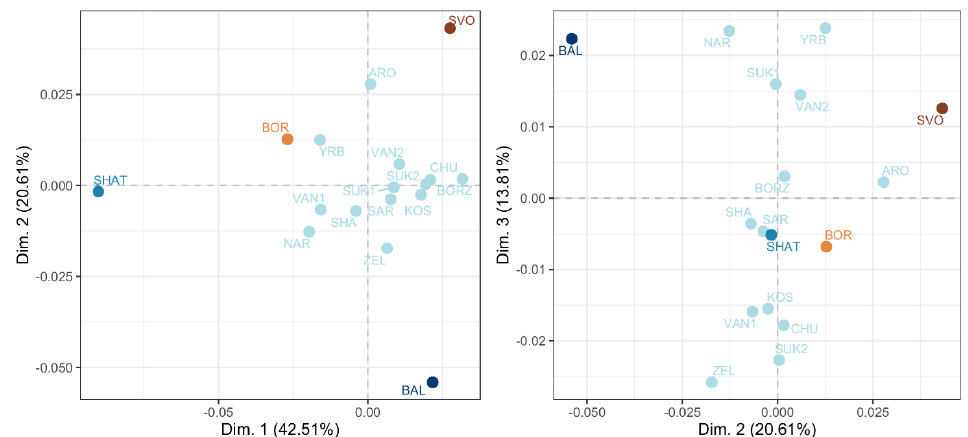
Figure 4. Two-dimensional plot of the three main principal components and their part of the total